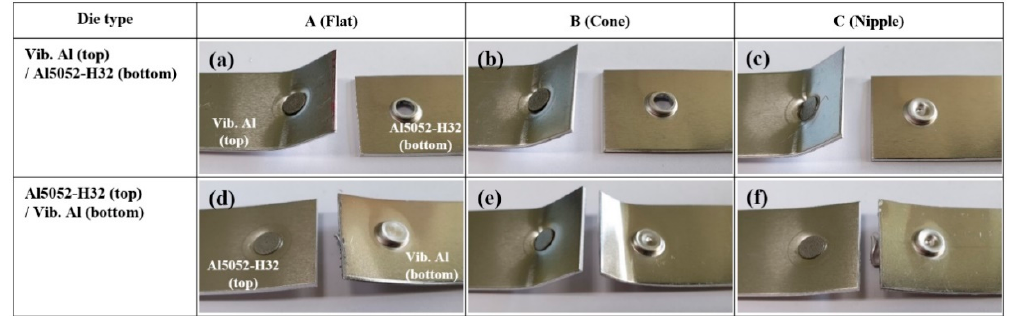
Figure 8. Failure modes of self-piercing riveted joints formed between vibration-damping Al and Al5052-H32 with respect to the die types and the panel configuration: ( a , d ) die type A , ( b , e ) die type B , and ( c , f ) die type C .